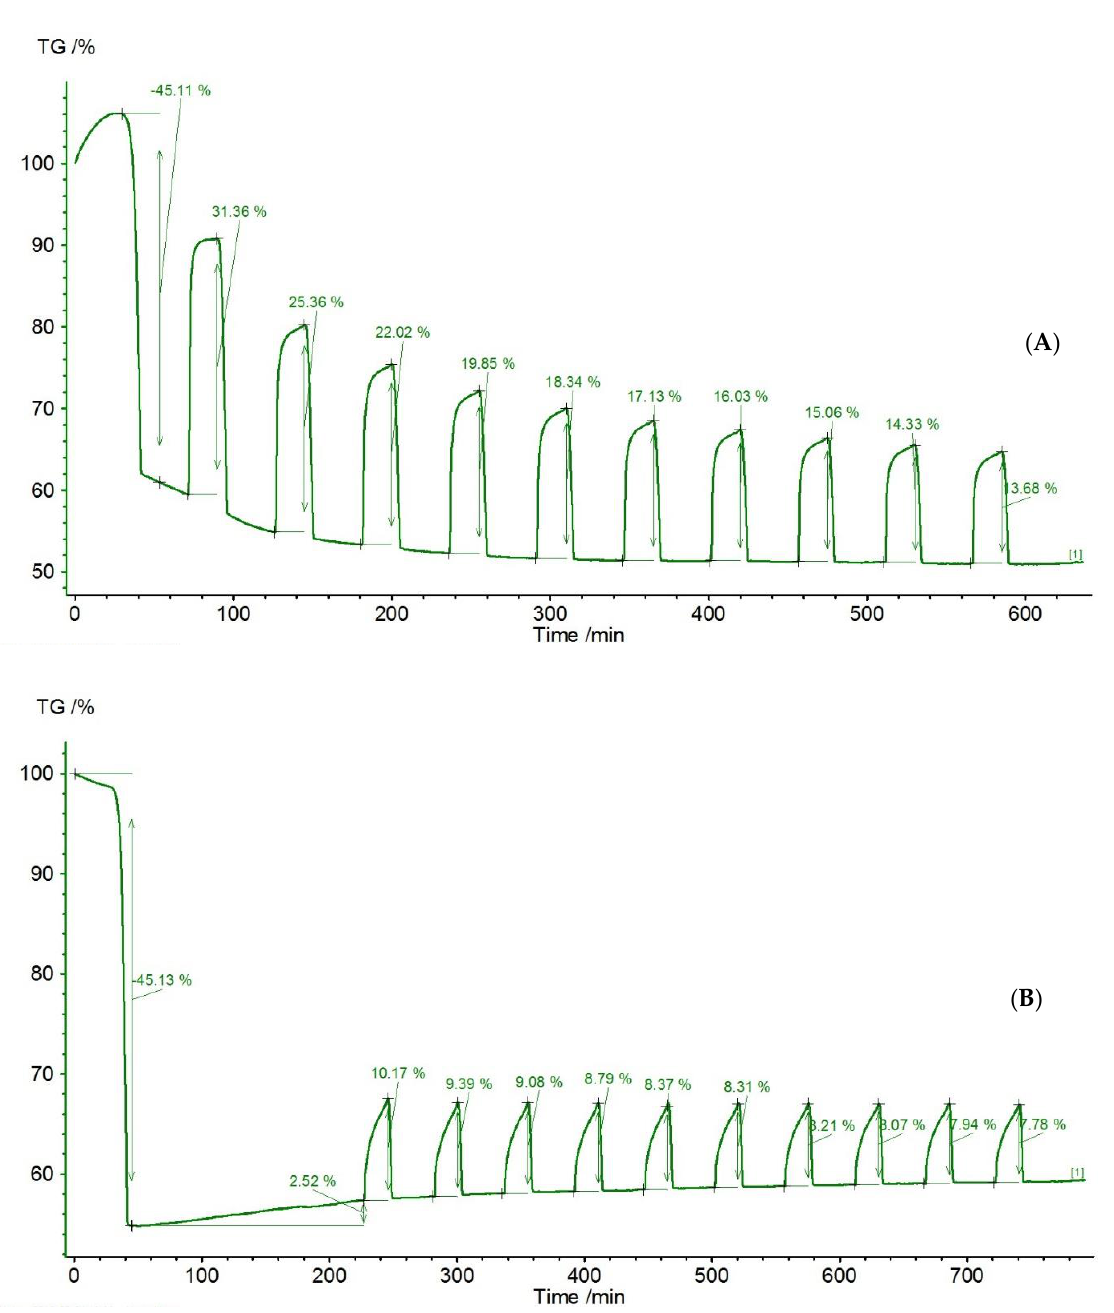
Figure 14. Relative mass changes for Stramberk limestone: ( A ) unmodified; ( B ) thermally pretreated for 1 h at 1000 °C. It is noteworthy that, within the assumed time of 10 min, the carbonation process was not completed. This is evident in the sample mass change graph, which shows a sharp rise (reaction stage) moving smoothly (transition stage) towards the diffusion stage. The latter, however, is not observed (no element approaching the horizontal line, mass growth curve). This means that in the case of the Stramberk limestone , carbonation could be car-